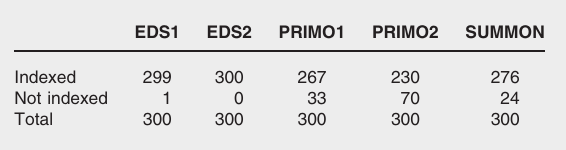
Of 120* results, source of relevant items (MEDLINE vs.